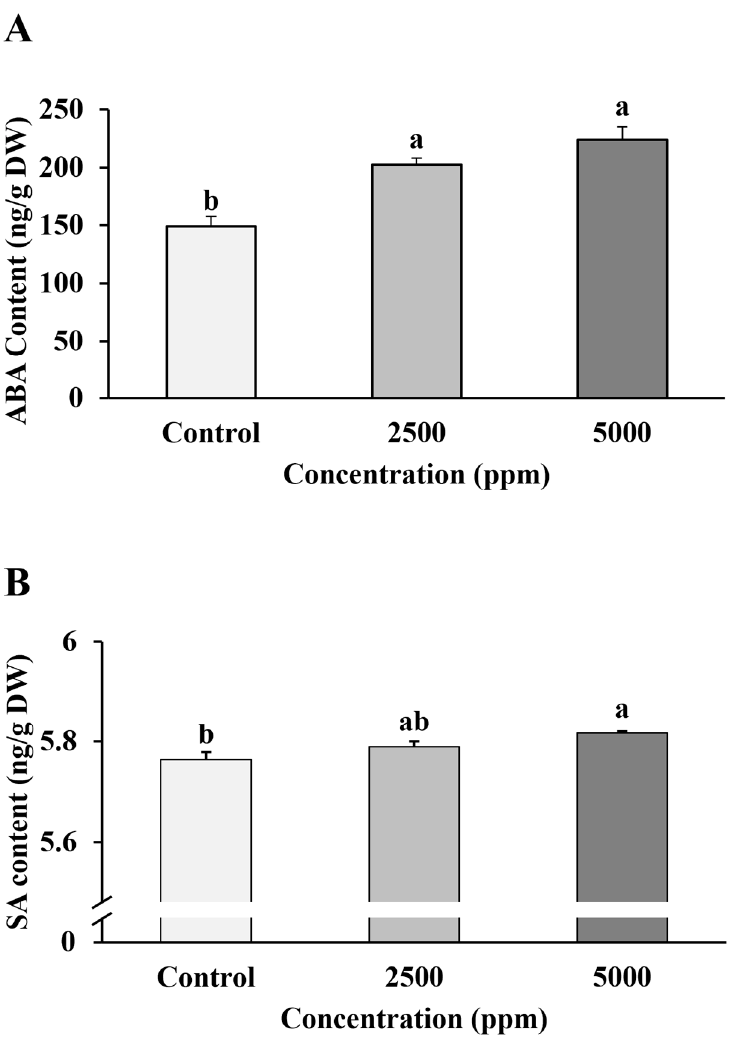
Figure 10. Effect of SCE treatment on abscisic acid (ABA) and salicylic acid (SA) content of Festuca arundinacea . Error bars represent standard deviations. Each data point represents the mean of at least three replications. Bars with different letters are significantly different from each other at p ≤ 0.05.